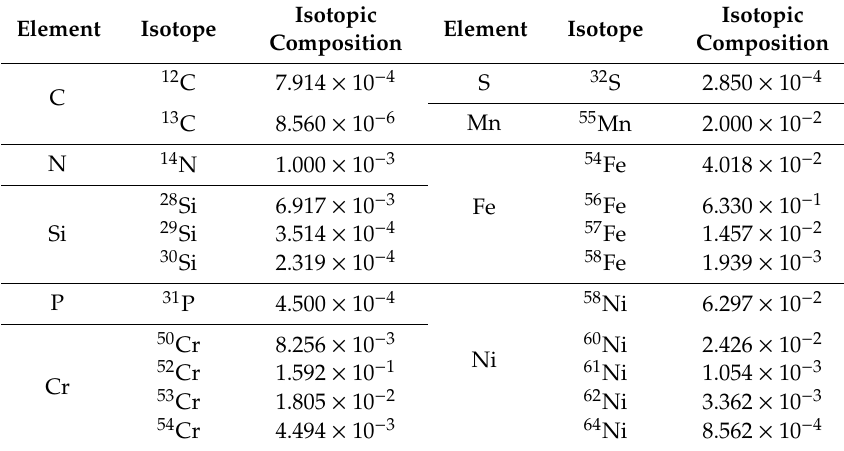
Table 4. Isotopic composition of the MPC-24 of the HI-STORM 100 DSS derived for the MCNP calculation.